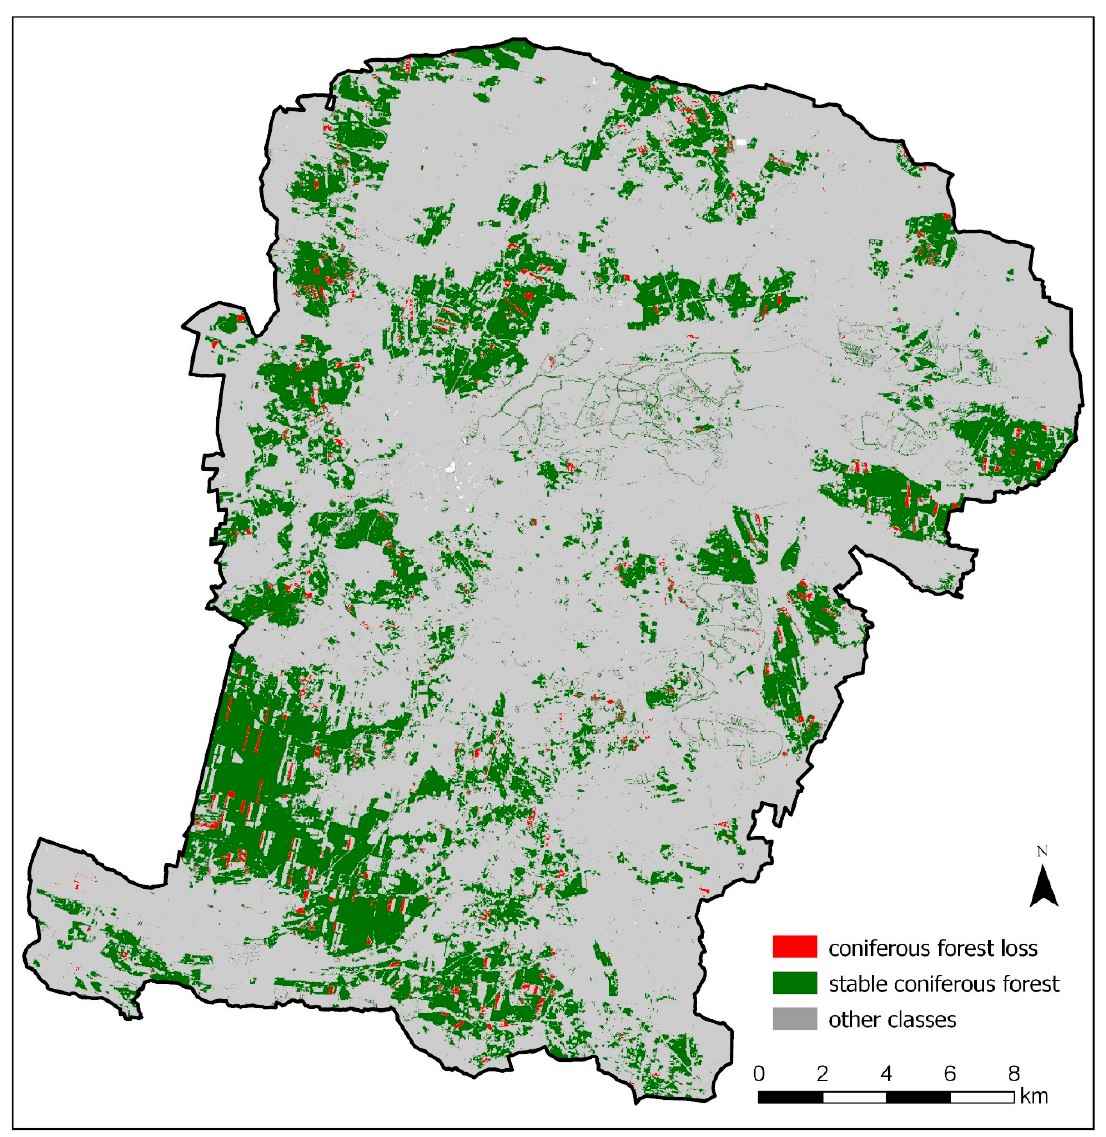
Figure 4. Coniferous forest cover changes in the years 2015–2019.